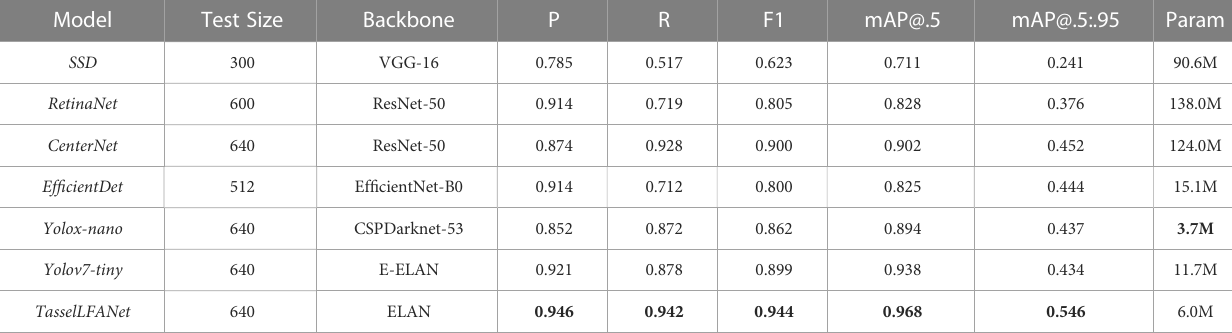
TABLE 4 Comparison of evaluation indicators of different models.